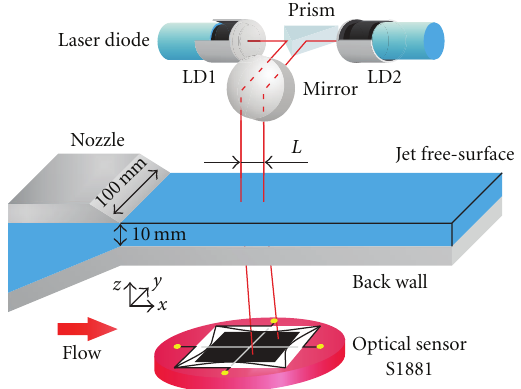
Figure 1: Schematic diagram of test section and optical system.